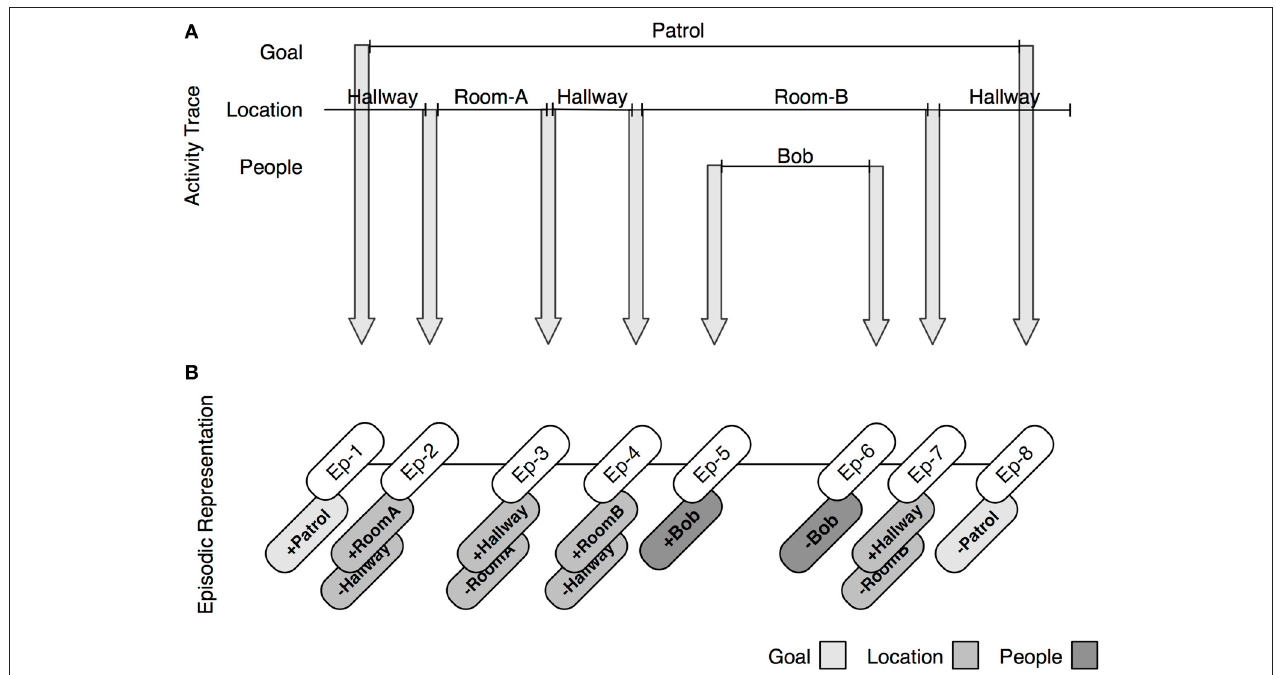
FIGURE 3 | The process by which episodes are encoded at event boundaries. (A) Shows a diagram of a trace of activity as a function of changes in goals, locations, and people. At each change, a new episodic marker is constructed (depicted as arrows). (B) Shows the representation of each episodic marker. Episodes are linked with symbolic information that describes the perceived changes at the time of encoding. Hence, episodes are used to uniquely describe a change in goal, location, person, and object (not